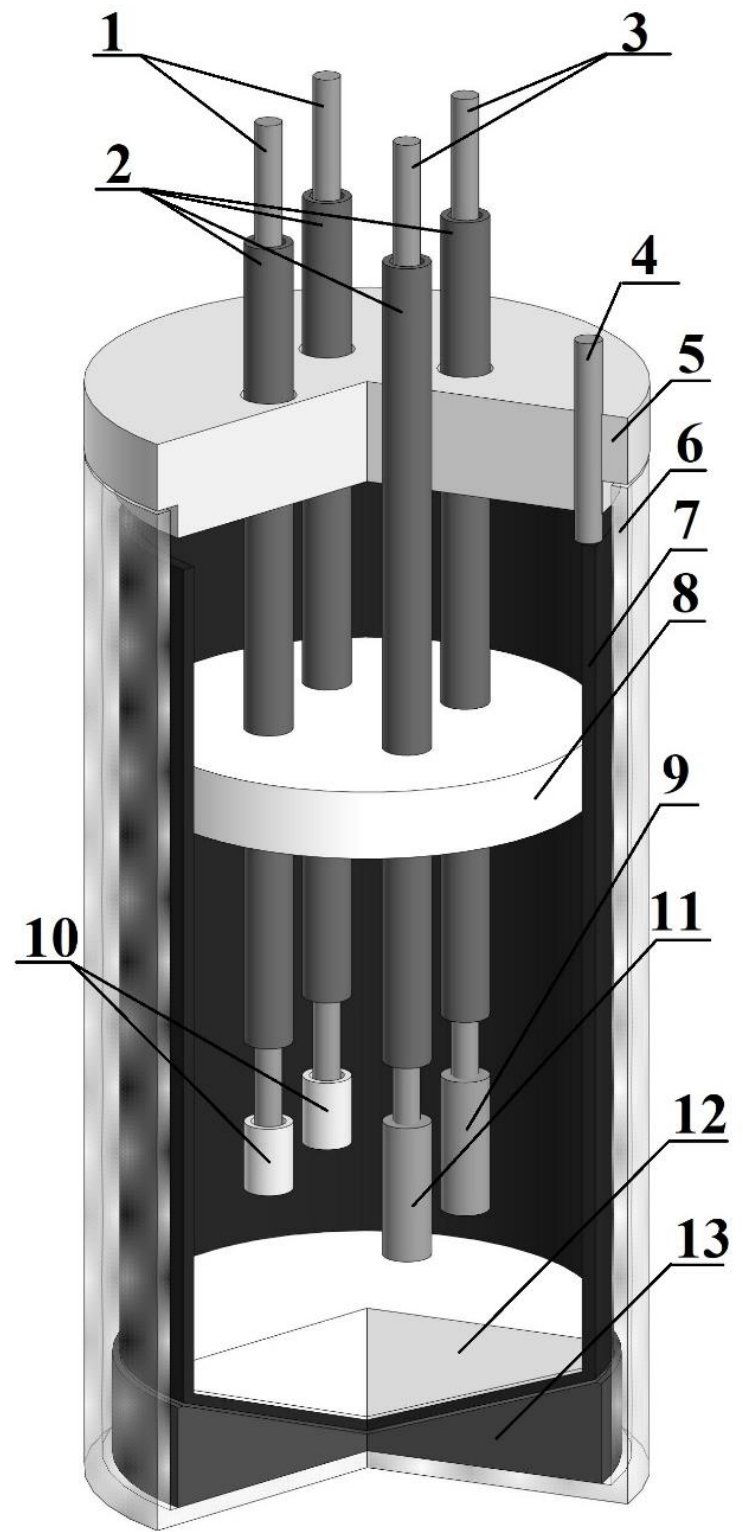
Figure 1. Schematic of the electrochemical cell. 1 — molybdenum electrodes; 2 — alundum straw; 3 — molybdenum current lead; 4 — nickel current lead; 5 — fluoroplastic cover; 6 — quartz retort; 7 — glassy carbon ampule; 8 — heat-resistant boron nitride screen; 9 — nickel electrode; 10 — nitride-boron isolator; 11 — iron electrode; 12 — melt; 13 — graphite platform. Table 1. Elemental analysis of the studied melts. Concentration, wt.%